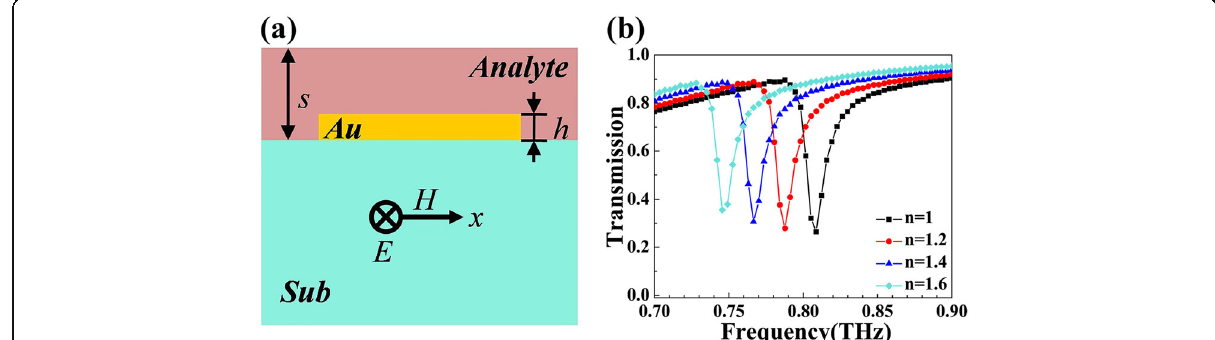
Fig. 5 a Cross section of the sensing device. b Dependence of transmission spectra on the changes of refractive index